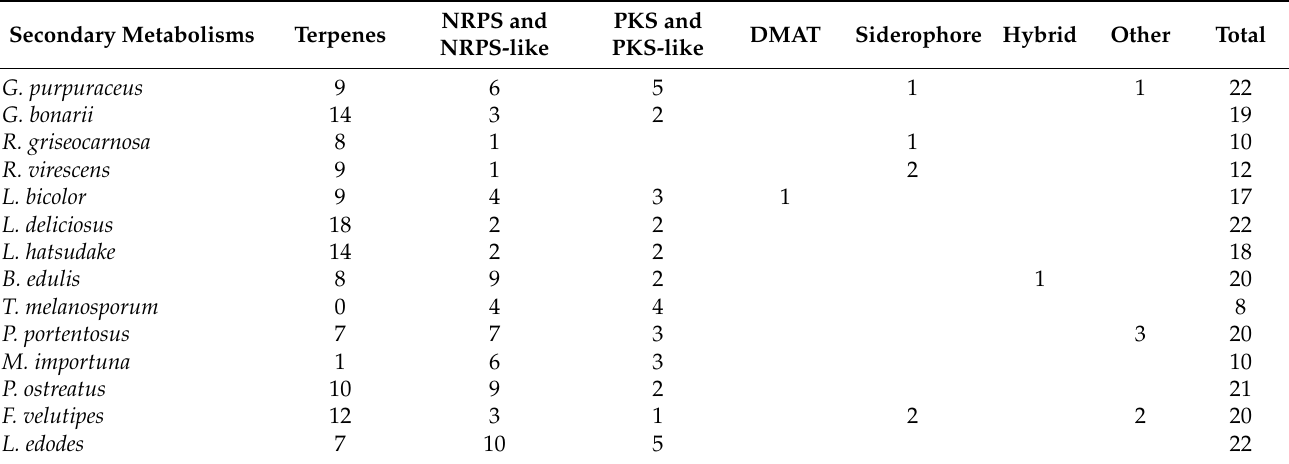
Table 3. Comparison of secondary metabolism of G. purpuraceus with 13 other